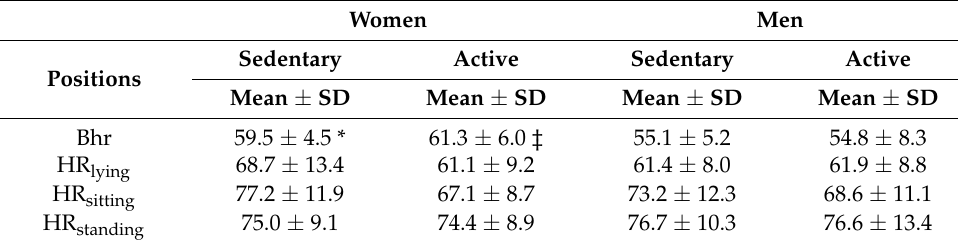
Table 2. Description of the heart rate measurement in different positions in young individuals of both